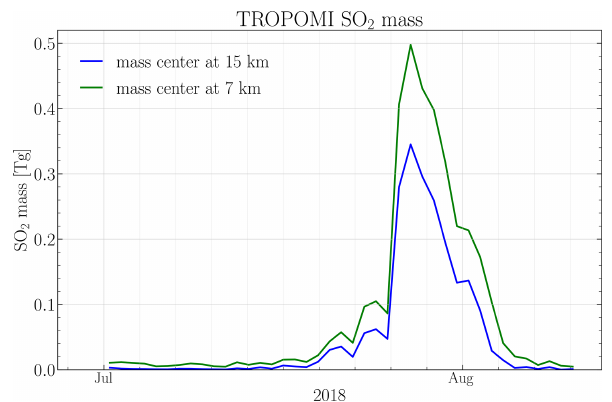
Figure B1. SO 2 mass from TROPOMI for the 7km (green line) and the 15km (blue line) SO 2